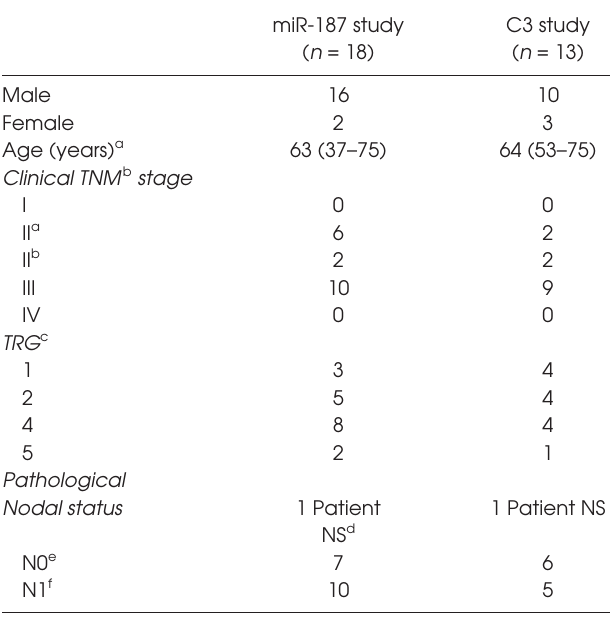
TNM, Tumor node metastasis clinical staging classification. c TRG, tumor regression